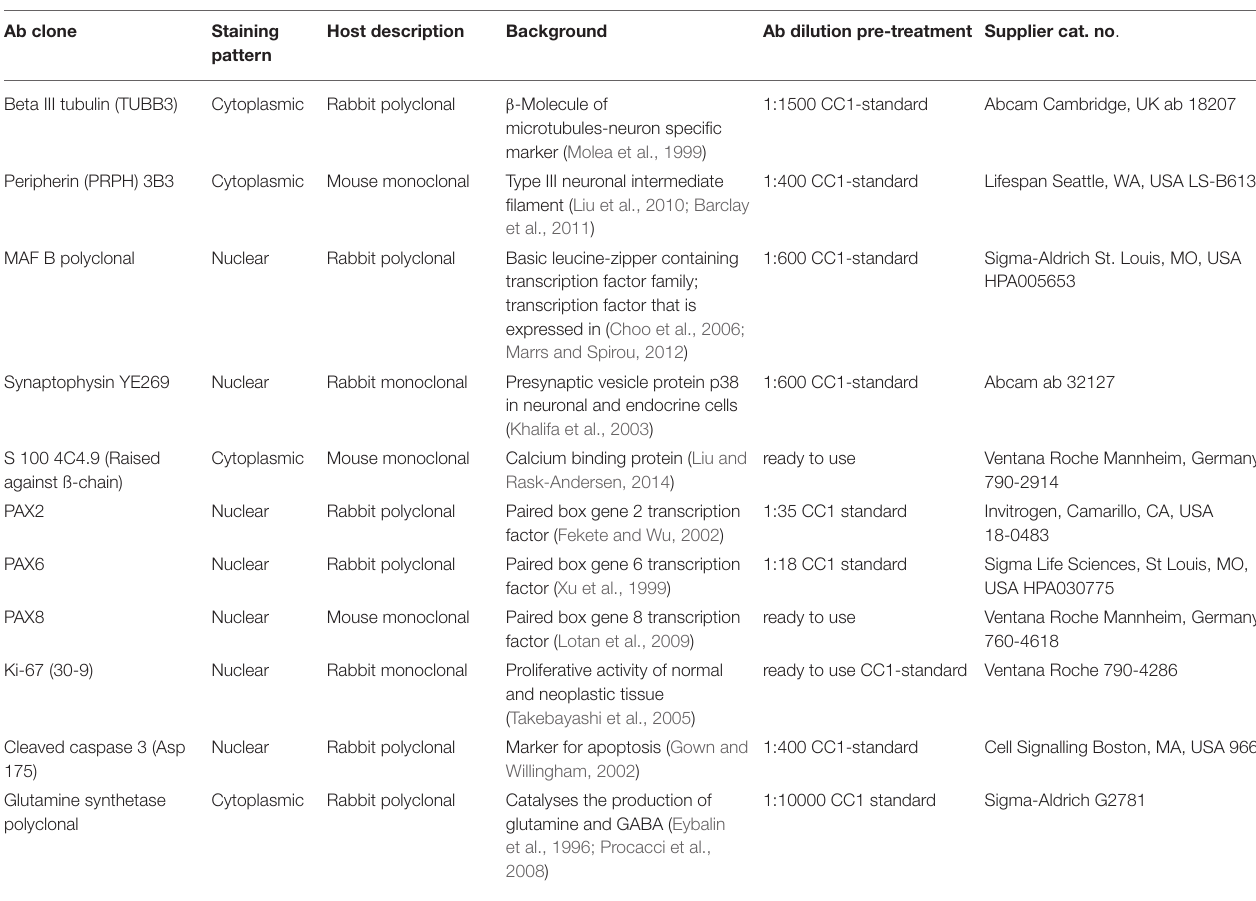
TABLE 1 | Antibodies used in this